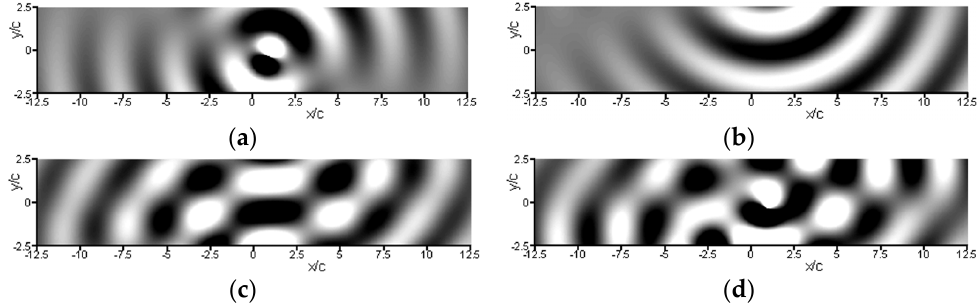
Figure 2. Low frequency ( St = 0.294) noise radiation from the trailing edge of an airfoil set at relatively high incidence ( α = 20 ◦ ). Instantaneous pressure fields, as recorded within the vein after 10 source periods: ( a ) Incident field ( p inc ( x , t = 10 T ) , cf. Equations (2) and (43)); ( b ) top wall reflected field ( 𝑝 (𝒙,𝑡) , cf. Equations (7) and (46)); ( c ) all reflected fields ( 𝑝 (𝒙, 𝑡 = 10𝑇) , cf. Equations (6) and (45); ( d ) total field ( 𝑝(𝒙, 𝑡 = 10𝑇) , cf. Equations (24) and (37)). For visualization purposes, all pressure fields are here normalized by A max and depicted over an amplitude range [ − 1; 1] using 60- iso contours.